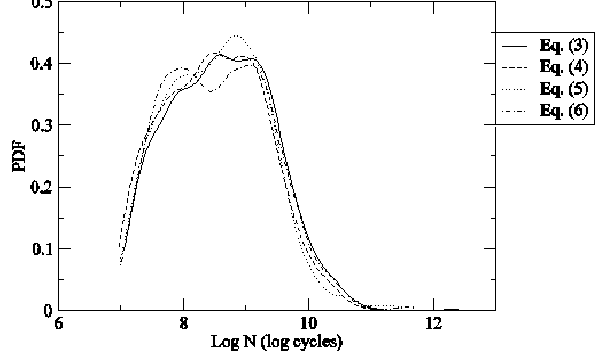
Fig. 7. Probability Density Functions for lifetime for each SIF expression (Eqs (2) to (5)). Second Monte Carlo